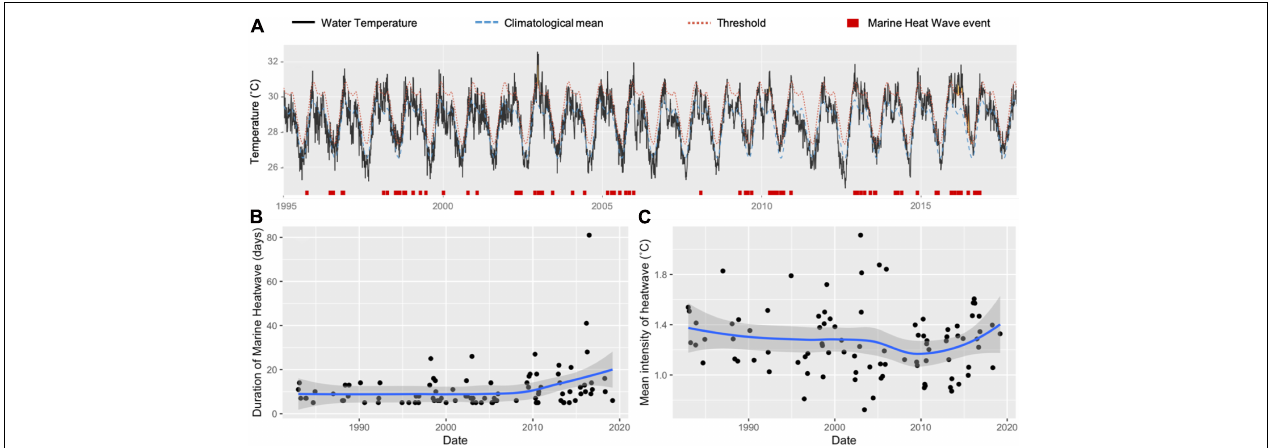
FIGURE 3 | Chronology of water temperature records from Ashmore obtained from remote sensing data between 1995 and 2019 (A) . Climatological means (broken blue lines) and thresholds (broken red lines) were calculated using the Marine Heatwave Tracker (Schlegel, 2018). Marine heat wave events are identified in red boxes as periods that exceed seasonally varied thresholds for at least 5 consecutive days (Hobday et al., 2016). (B) shows the historic trend in duration of marine heatwaves (days), while (C) shows the intensity of heatwaves ( ◦ C) at Ashmore between 1982 and 2019. Trendlines estimated using Generalised Additive Models with standard error estimate bounds represented as grey